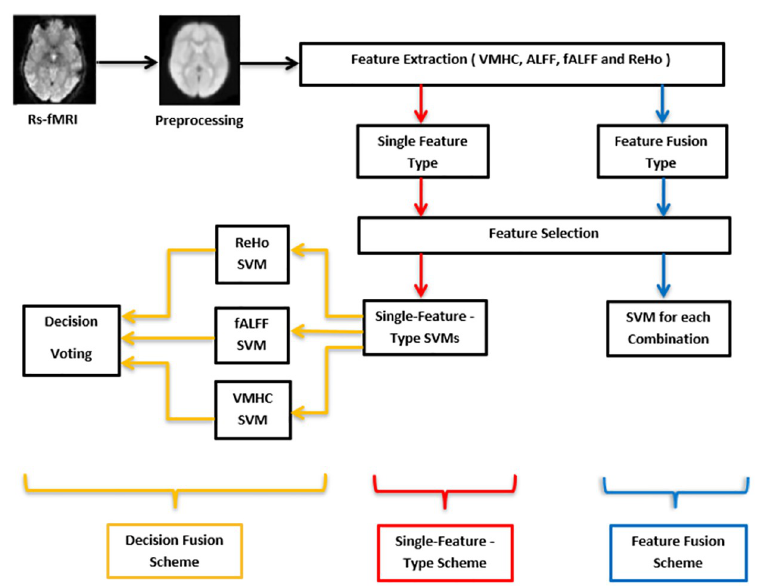
Fig 5. Schizophrenia detection performance outcomes under the Rician noise conditions for the best classifiers with single, pairwise, triple, and quadruple feature combinations as well as the decision-fusion classifier.